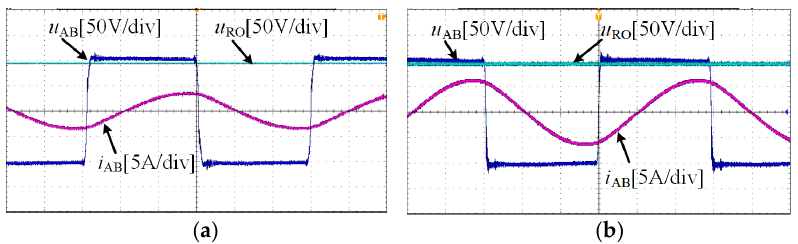
Figure 13. Waveforms of the CVO-type LCC-S compensation topology in Case C: ( a ) R O = 100 Ω , k = 0.5; ( b ) R O = 100 Ω , k = 0.25.